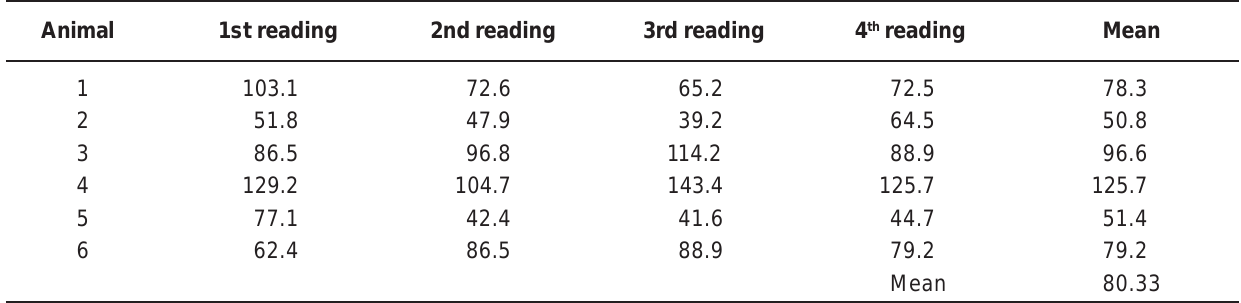
TABLE 2 - Mean nitric oxide release in µ mols of Endofill cement in peritoneal macrophage culture obtained from six Swiss mice